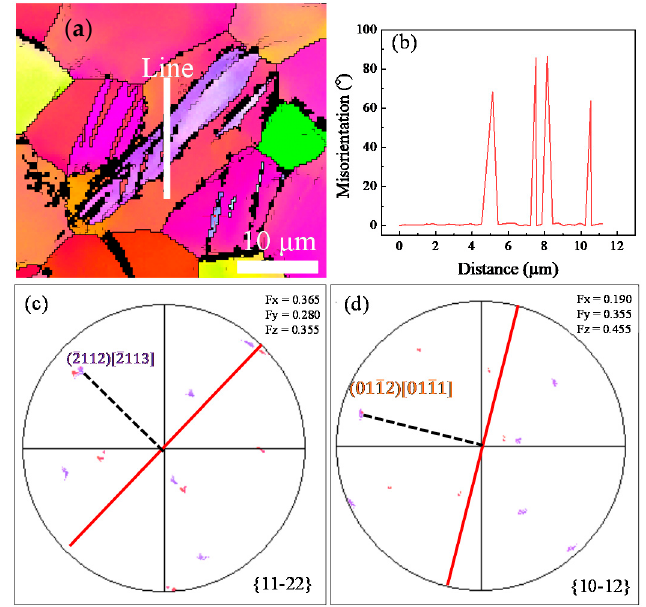
Figure 3. Variant analysis of primary twin and secondary twin: ( a ) IPF; ( b ) misorientation between primary twin and secondary twin; ( c , d ) pole figures (PFs) of primary and secondary twin variants.